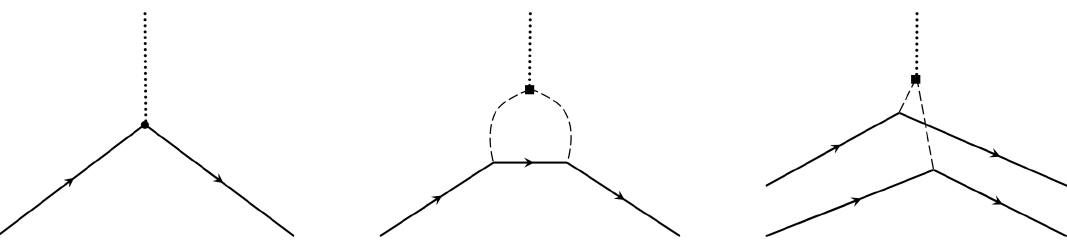
Figure 1 . Diagrams contributing to the axion-nucleon interactions. The solid lines correspond to nucleons, the dotted lines to axions, and the dashed lines to